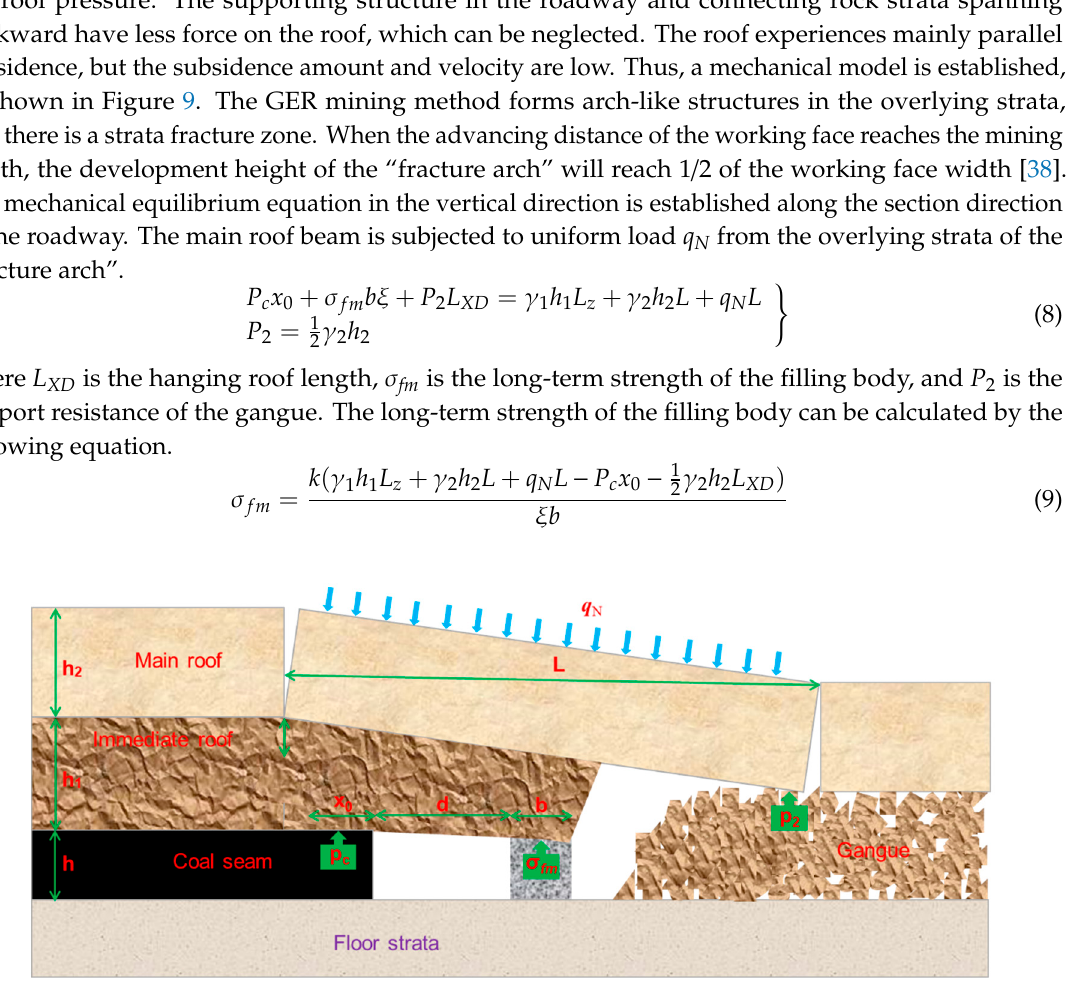
Figure 9. Later mechanical model.